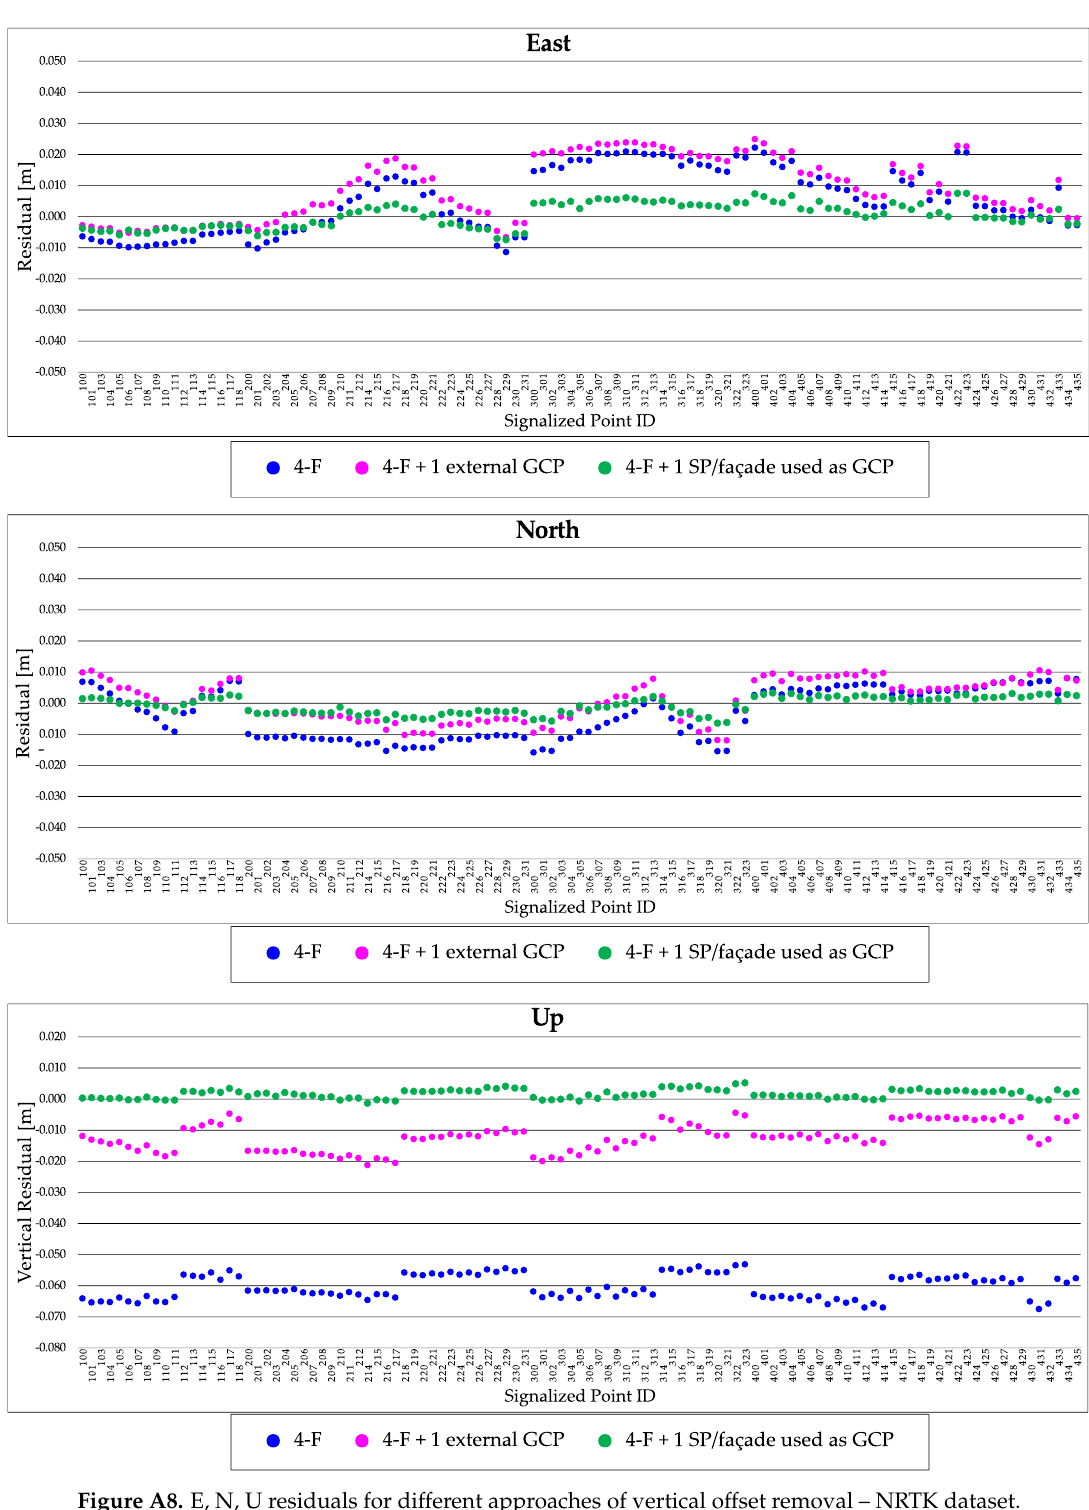
Figure A8. E, N, U residuals for different approaches of vertical offset removal – NRTK